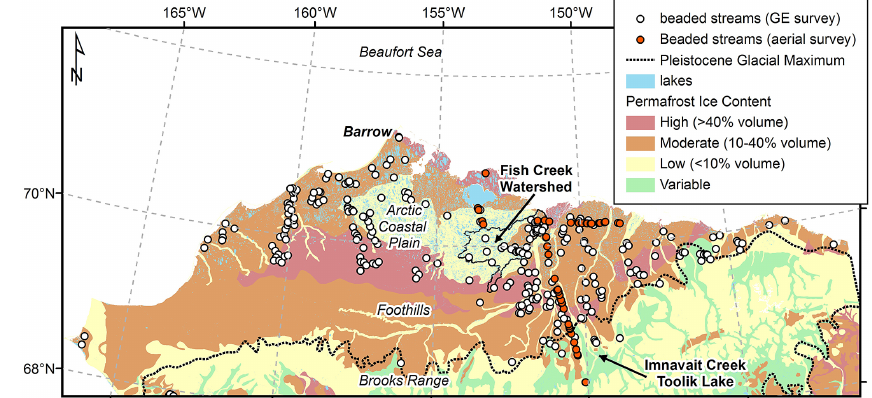
Figure 2. The distribution of beaded streams located using Google Earth and from aerial surveys across the North Slope of Alaska in relation to permafrost ice content (Jorgenson et al., 2008) and the Pleistocene glacial maximum (Manley and Kaufman, 2002). The locations of the Fish Creek watershed (focus area of this study) and Imnavait Creek (focus area of the majority of pervious work on beaded streams) are indicated.